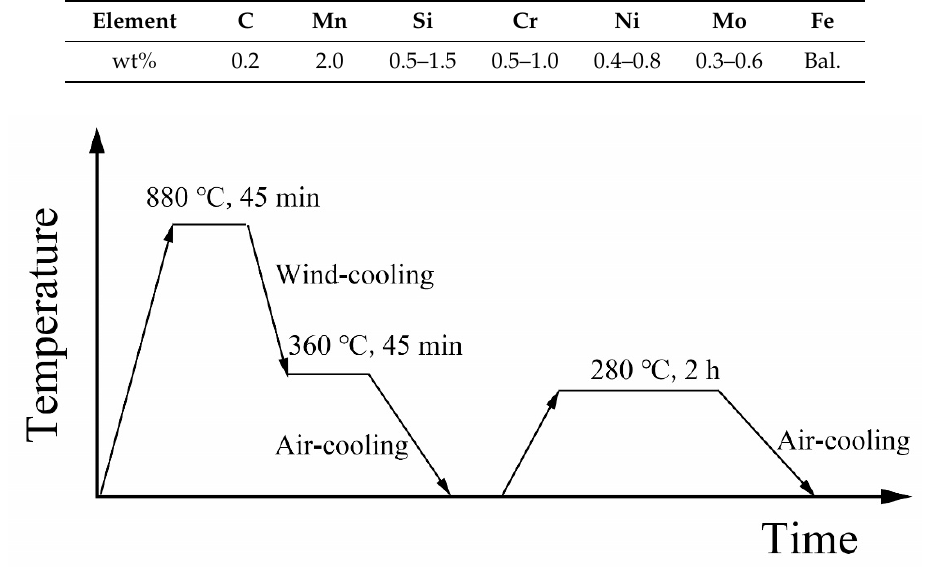
Table 1. Chemical compositions of steel (wt%).